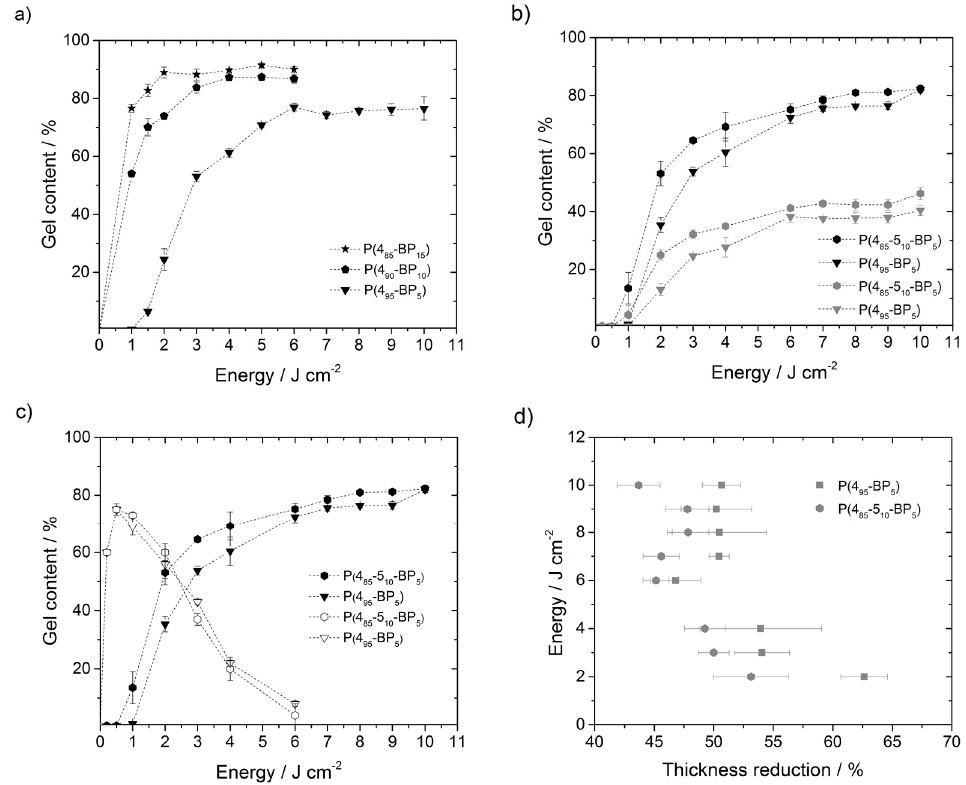
Figure 2. Gel content of surface-attached polymer networks and hydrogels made from different P(4-5-BP) polymers as a function of the irradiation energy dose: ( a ) Polymers with varying amount of benzophenone repeat units (5–15 mol %, respectively), irradiated at λ = 365 nm (Table S4); ( b ) polymers with 5% benzophenone repeat units and varying amounts of co-repeat units, black symbols = N -Boc protected polymers, grey symbols = deprotected polymers, irradiated at λ = 365 nm (Table S5); ( c ) Comparison of cross-linking of the protected P(4 85 -5 10 -BP 5 ) and P(4 95 -BP 5 ) at λ = 365 nm (filled symbols, Table S5) and λ = 254 nm (open symbols, Table S3); ( d ) Thickness reduction due to deprotection of the N -Boc protected polymeric layers consisting of P(4 85 -5 10 -BP 5 ) and P(4 95 -BP 5 ) as a function of the irradiation energy dose (Table S5). P(4 95 -BP 5 ) = ( M1 / M4 / M5 5:95:0), P(4 90 -BP 10 ) = ( M1 / M4 / M5 10:90:0), P(4 85 -BP 15 ) ( M1 / M4 / M5 15:85:0)) ( P(4 85 -5 10 -BP 5 ) ( M1 / M4 / M5 5:85:10) and P(4 95 -BP 5 ) ( M1 / M4 / M5 5:95:0).